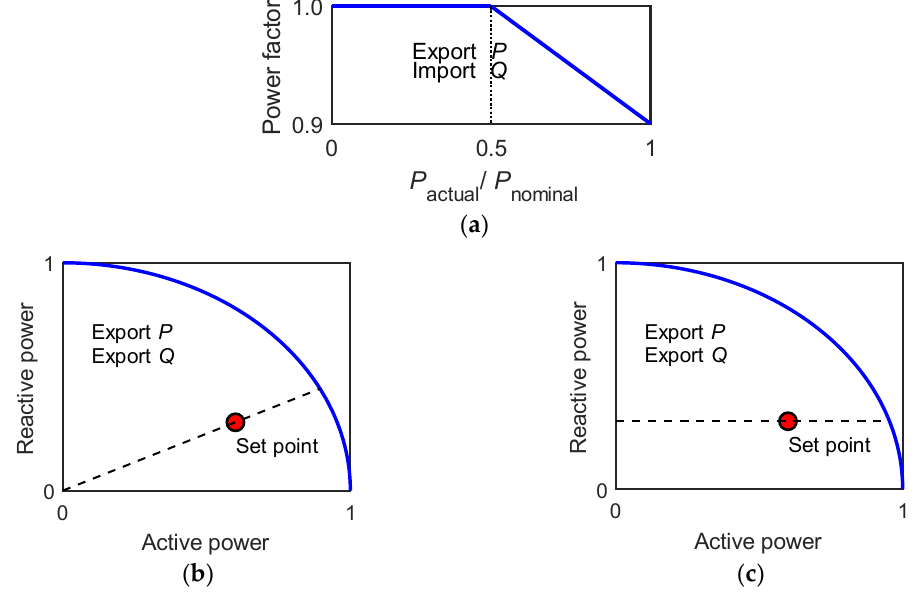
Figure 2. The demonstration of three reactive power control methods: ( a ) PF ( P ) control; ( b ) Constant PF control; ( c ) Constant Q control. PF control; ( c ) Constant Q